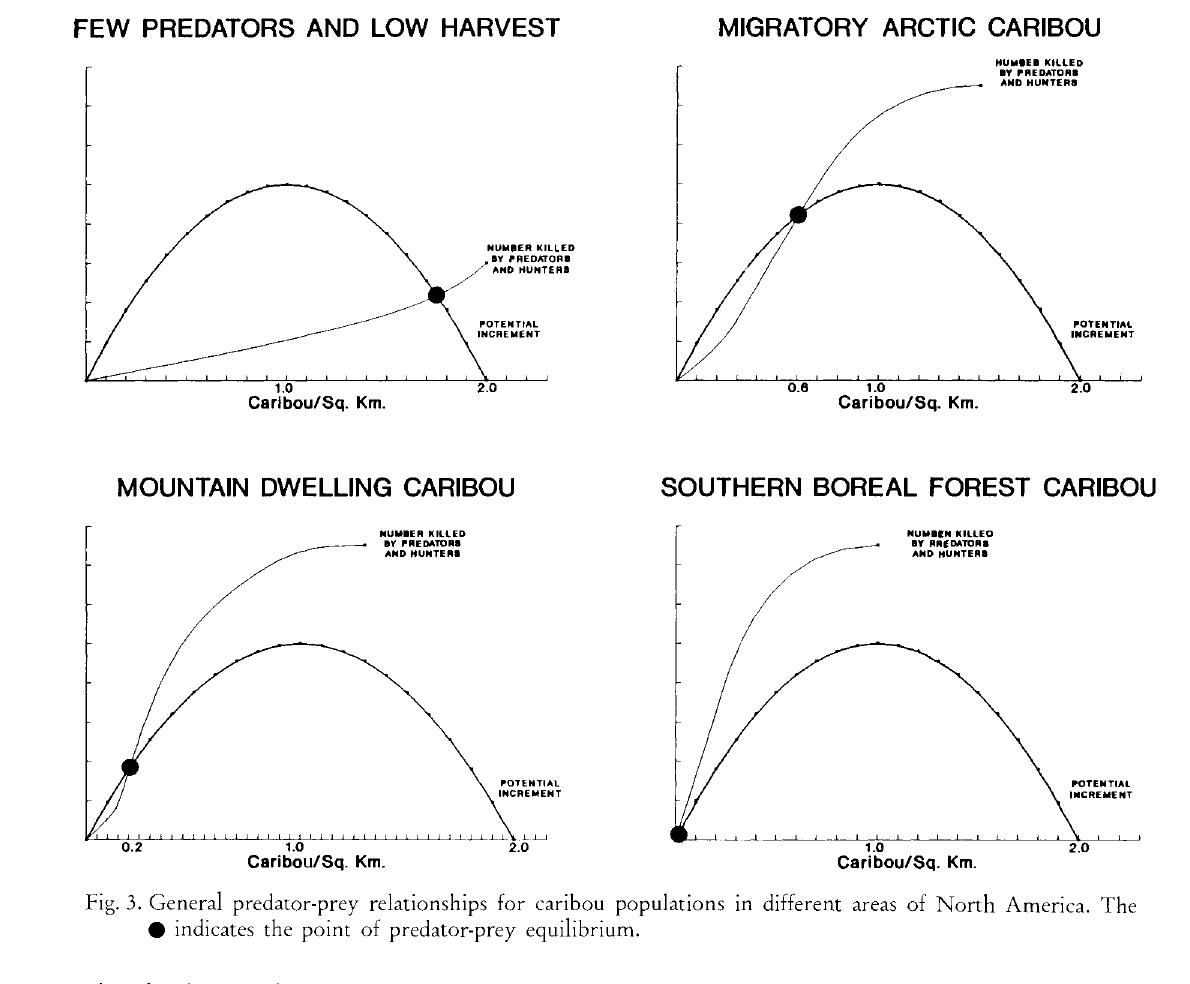
Fig. 3. General predator-prey relationships for caribou populations in different areas of North America. The • indicates the point of predator-prey equilibrium. ribou herd in northern Quebec which attained a density of about 1/km 2 (Messier etal. 1988). A high mortality rate of wolves and a low human harvest of caribou will increase the likelihood that migratory Arctic caribou will escape from being regulated by